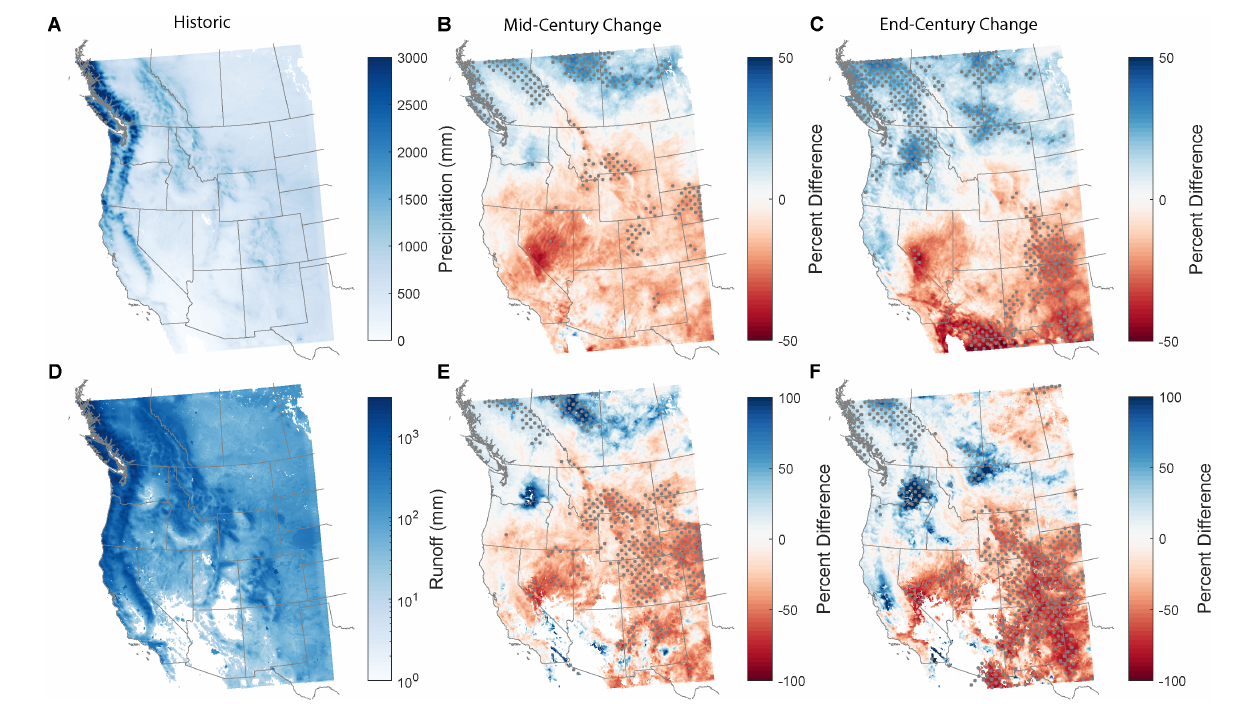
FIGURE 3 | (A) Average annual total precipitation from WRF/CCSM for the historical decade. (B,C) Percent difference in annual precipitation when comparing the mid-century (B) and end-century (C) decades to the historic. (D) Average annual total runoff from WRF/CCSM for the historical decade. (E,F) Percent difference in annual runoff when comparing the mid-century (E) and end-century (F) decades to the historic. Stippling indicates regions with a statistically significant change by mid- or end-century at the 95% confidence